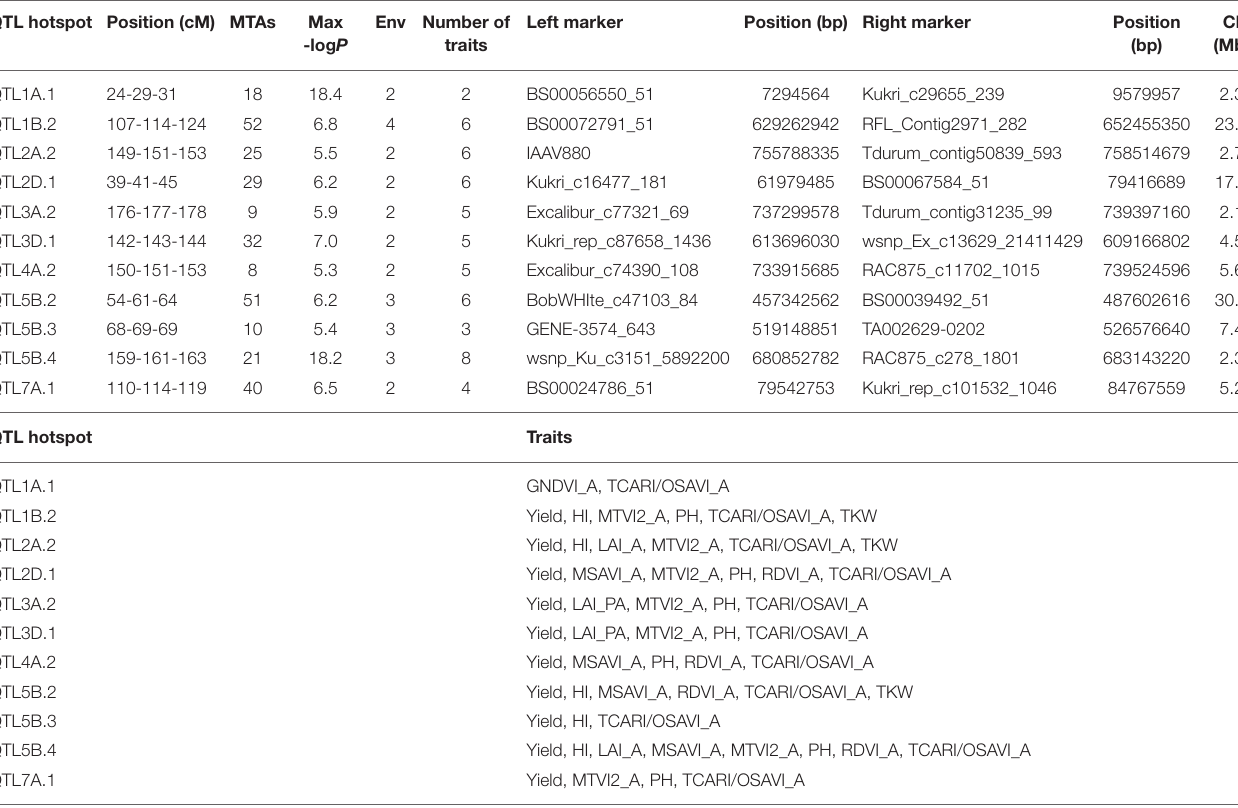
TABLE 8 | QTL hotspots identified for agronomic and remotely sensed VI-related traits. QTL hotspot Position (cM) MTAs Max